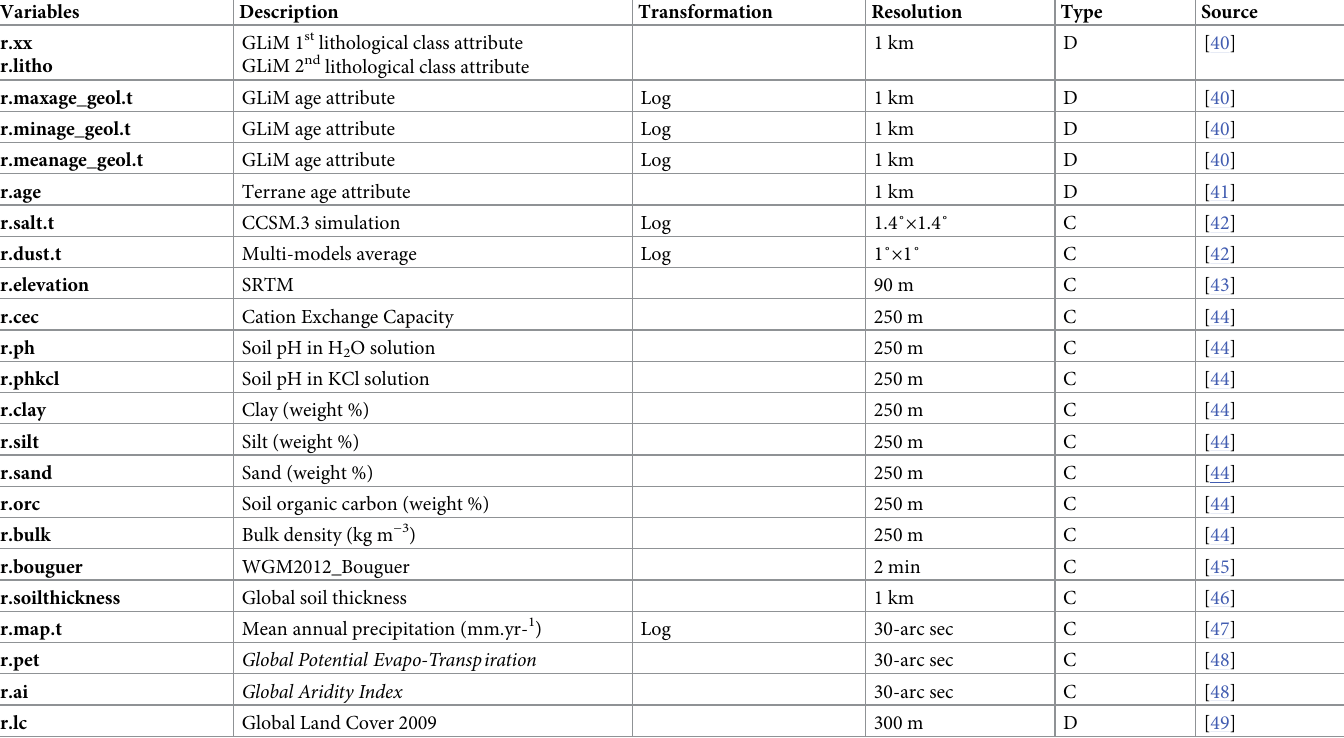
Table 2. List of geological, climatic, environmental and topographic variables used in the regression. D = Discrete; C = Continuous; GLiM = Global Lithological Map; CCSM.3 = Community Climate System Model 3; SRTM = Shuttle Radar Topography Mission.